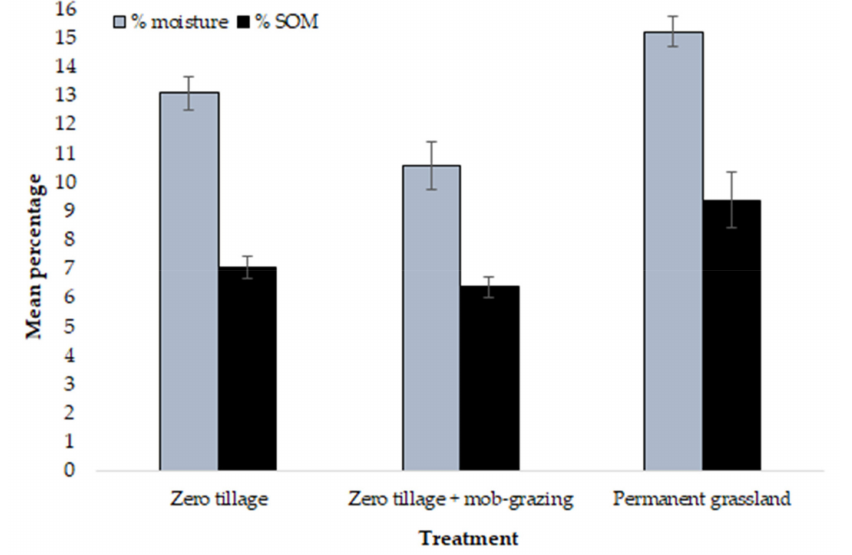
Figure 3. Mean percent soil moisture and soil organic matter (SOM) for three treatments (ZT: zero tillage; ZTMG: zero tillage + mob-grazing; PG: permanent grassland), n = 10 per treatment. Error bars ± one standard error of the mean.